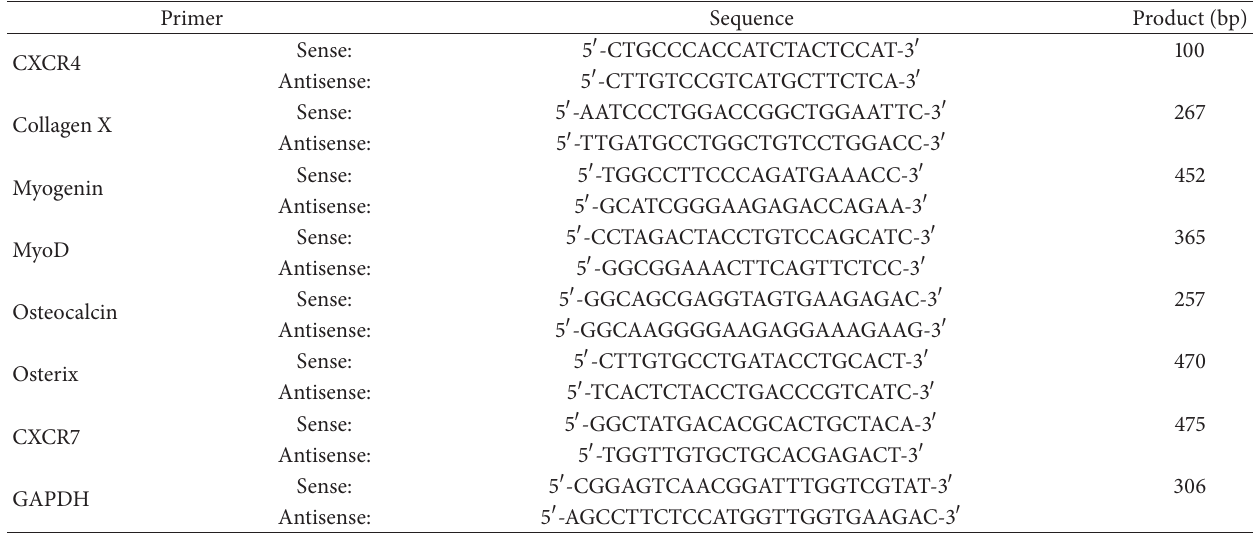
Table 1: Primers used for gel-based RT-PCR